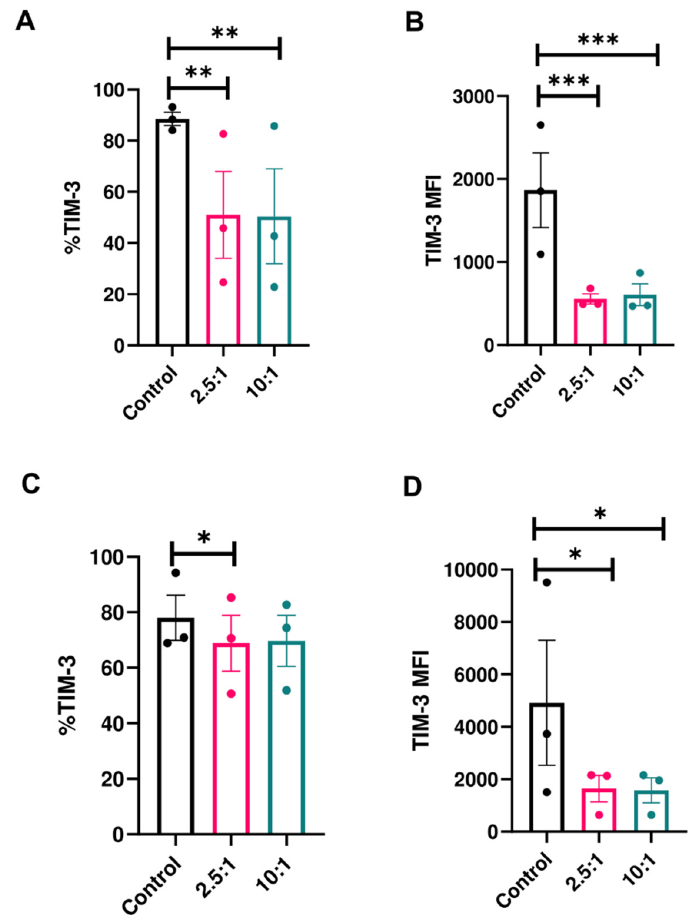
Figure 2. Expression of TIM-3 on NK cells in response to cancer cells (mean ± SEM). Percentage (left panels) and MFI (right panels) of TIM-3 on human peripheral blood NK cells in response to ( A , B ) Prostate cancer (PC3) ( n = 3 donors) and ( C , D ) primary human glioblastoma (GBM43) cells ( n = 3) after 4-h co-culture at E:T ratios of 2.5:1 and 10:1.* p < 0.05, ** p < 0.01, *** p < 0.001